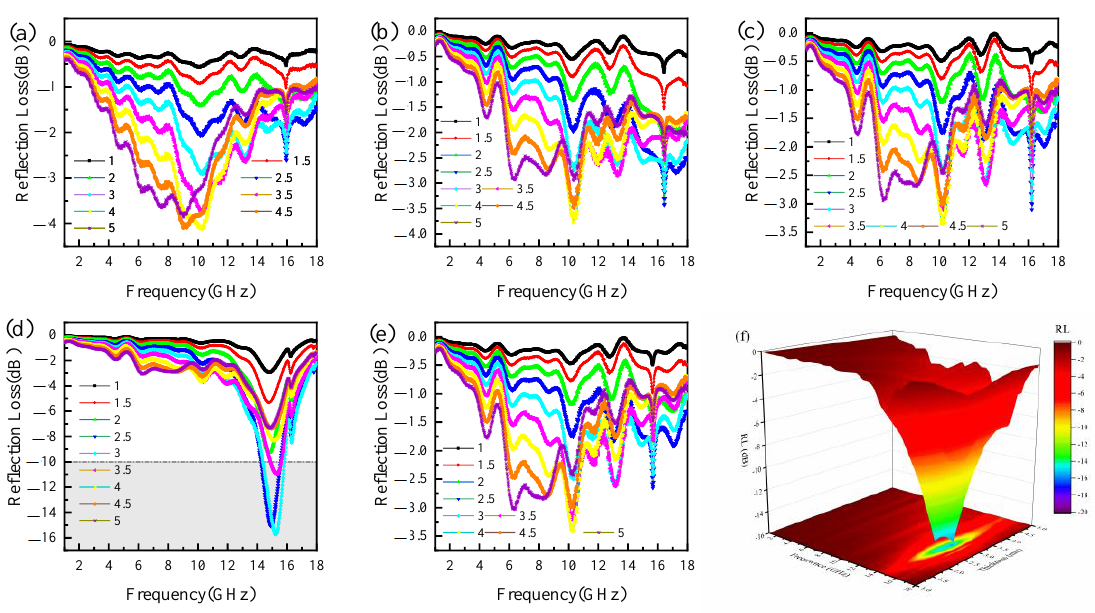
Figure 9. Reflection loss curves of the samples at different thicknesses: ( a ) B1, ( b ) B2, ( c ) B3, ( d ) B4, ( e ) B5, and ( f ) three-dimensional representation of reflection loss of B4.